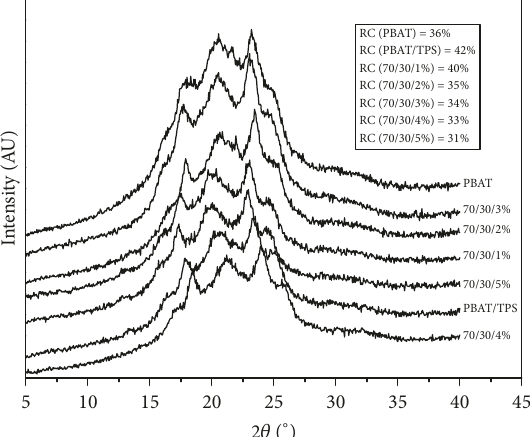
Figure 4: X-ray diffraction patterns and relative crystallinity (RC) of the films.